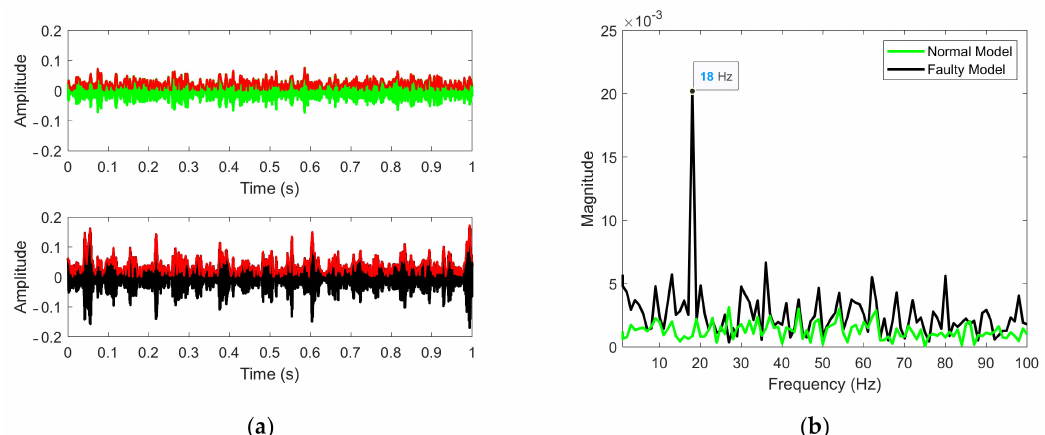
Figure 3. Process of envelope analysis: ( a ) band-pass filtered signal models and envelope signals in time domain (top: normal signal model, bottom: faulty signal model); ( b ) envelope